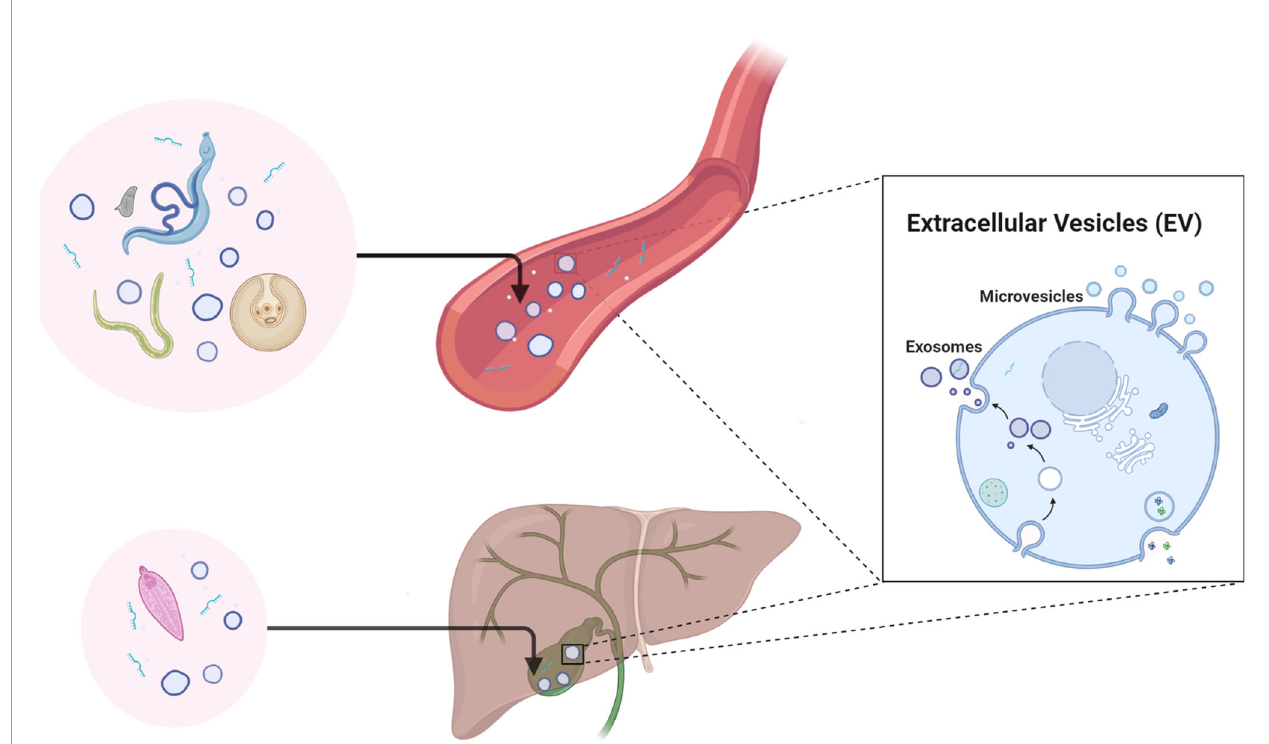
FIGURE 1 | Diagrammatic representation of the secretion of helminth-derived non-vesicular extracellular miRNAs and/or EVs in the circulatory system and bile of the mammalian host. Figure 1 was created with